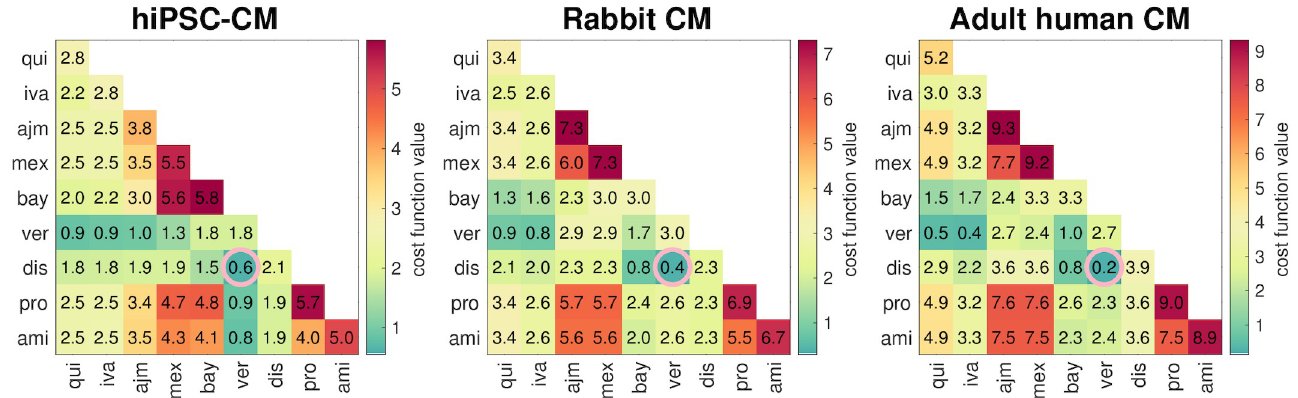
Fig 3. Optimal cost function values obtained by applying our computational procedure to combinations of two drugs, selected for their potential to repair the SQT1 mutation in hiPSC-CMs, rabbit ventricular CMs and adult human ventricular CMs. The numbers in the upper left to lower right diagonal report the cost function values found in searches for the optimal dose of a single drug. In addition, the pink circles indicate the lowest cost function value obtained in each case.